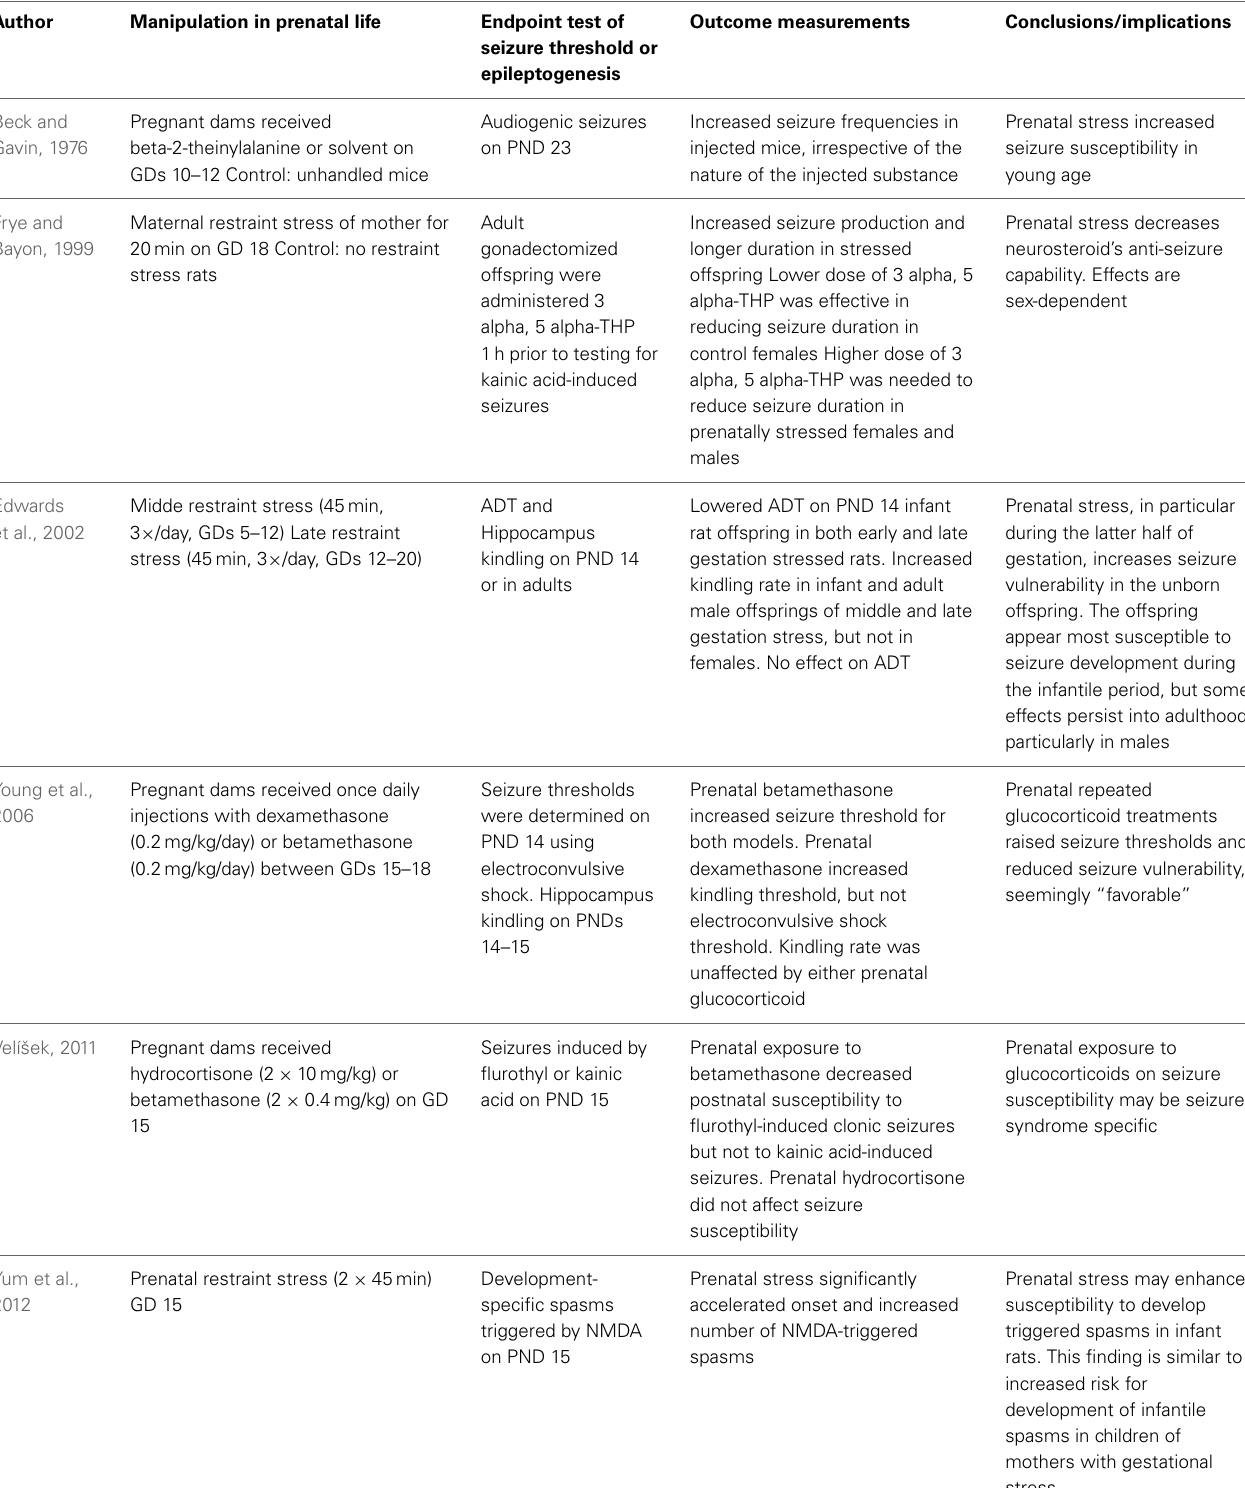
Table 1 | Summary of rodent studies investigating effects of prenatal stress in rodent models of